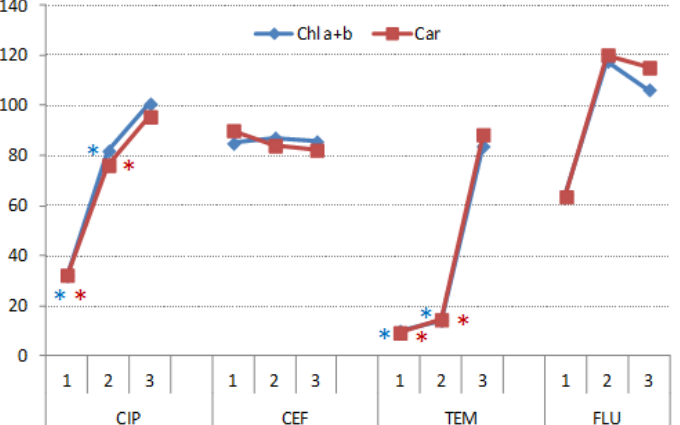
Figure 14. Concentration of photosynthetic pigments (chlorophylls a and b and carotenoids) in the leaves of wheat germinated under CIP, CEF, TEM and FLU treatments and subsequently grown on complete nutrient solution, recorded in 11-day-old plants. The results are expressed relative to respective controls (control = 100%). Asterisks mark values were significantly different from respective controls.